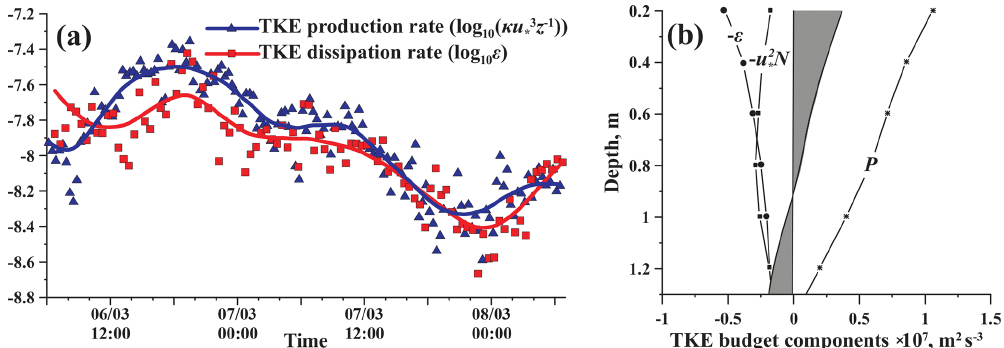
Figure 9. TKE production–dissipation balance in the ice boundary layer. (a) TKE production and dissipation rates at the depth of 0.85m beneath the ice base. Bold lines are the values filtered by a moving average with a 6h window. (b) Vertical profiles of the TKE budget components in Eq. (14) averaged over the 2d period of measurements. Data are presented for station S1 only; the S2 results are qualitatively the